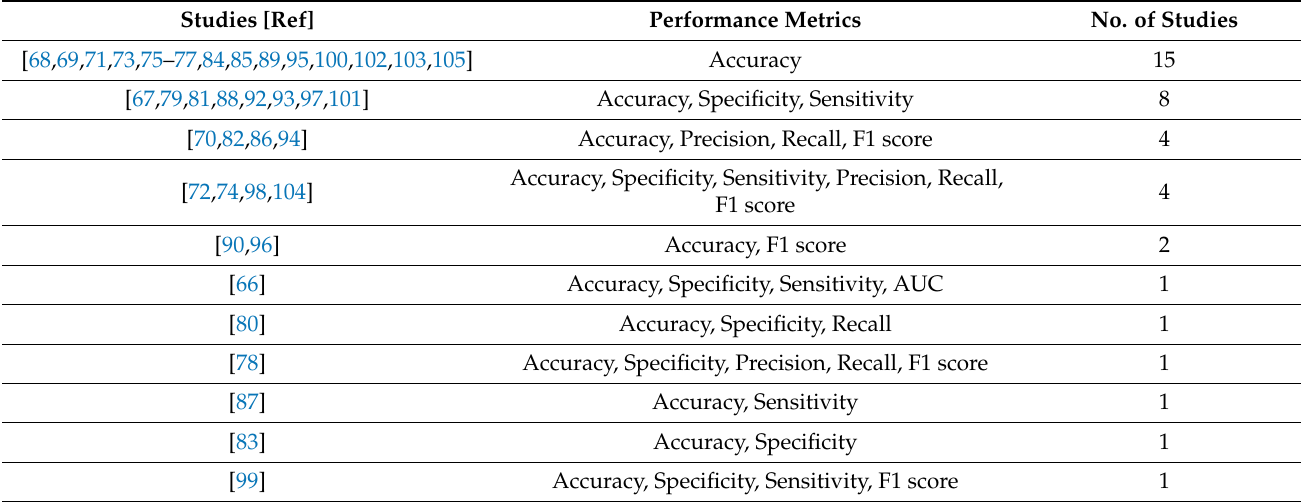
Table 3. Frequency count of performance metrics utilized in every chosen